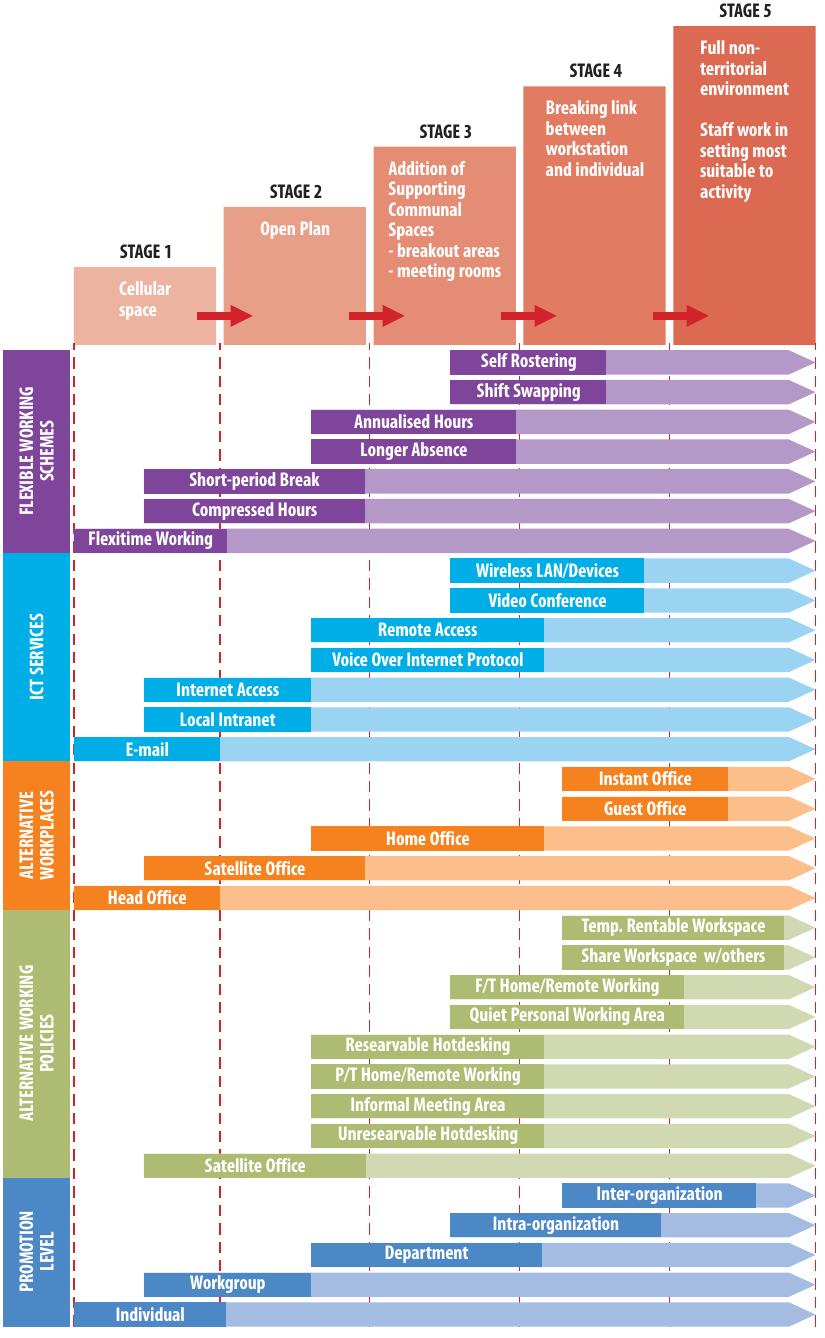
Figure 3. Proposed applications for evolution stages (adapted from Gibson and Luck,